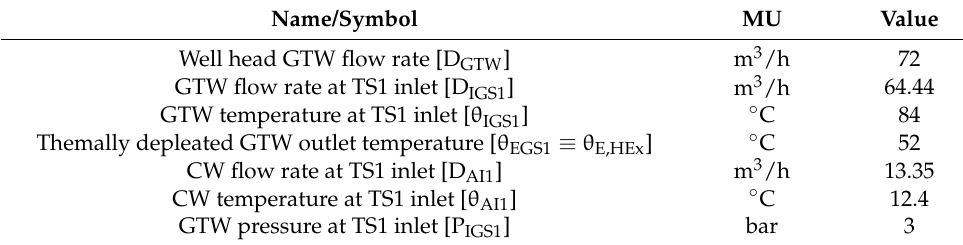
Table 5. Measurement data collected 20–22 January 2020 (average